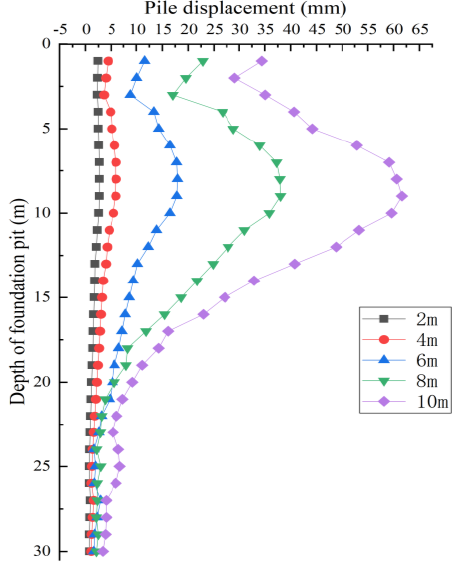
Figure 6. Horizontal displacement of front row inclined pile.